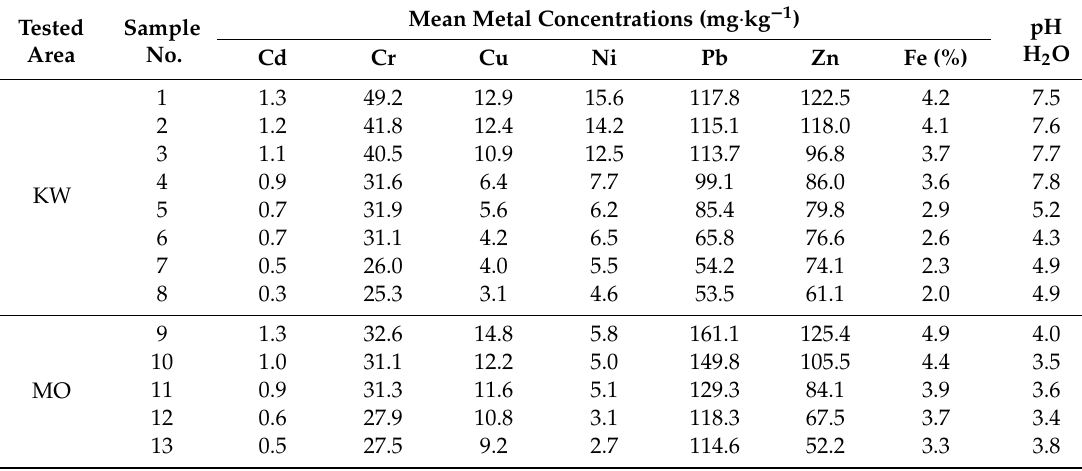
Table 3. Heavy metal content (average values) and soil reaction in the Kasprowy Wierch and Morskie Oko test